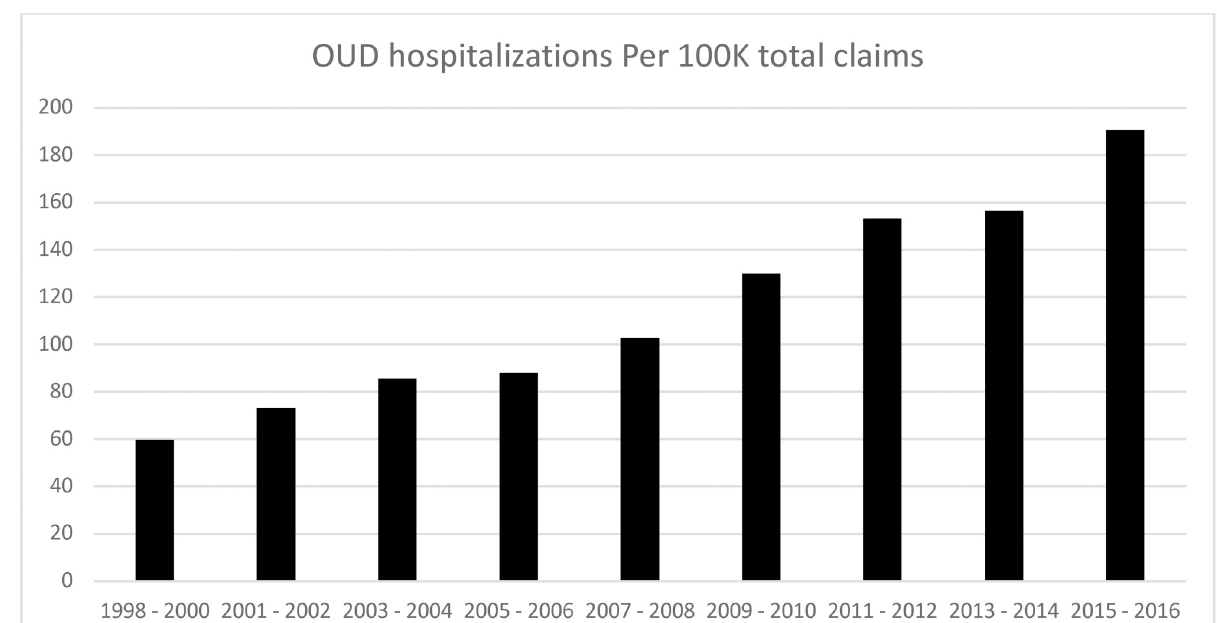
Fig 1. Time-trend in OUD hospitalization rate per 100,000 NIS claims from 1998 to 2016. X-axis represents time-periods from 1998–2000 to 2015– 16. Y-axis shows primary OUD hospitalization rates per 100,00 NIS claims.